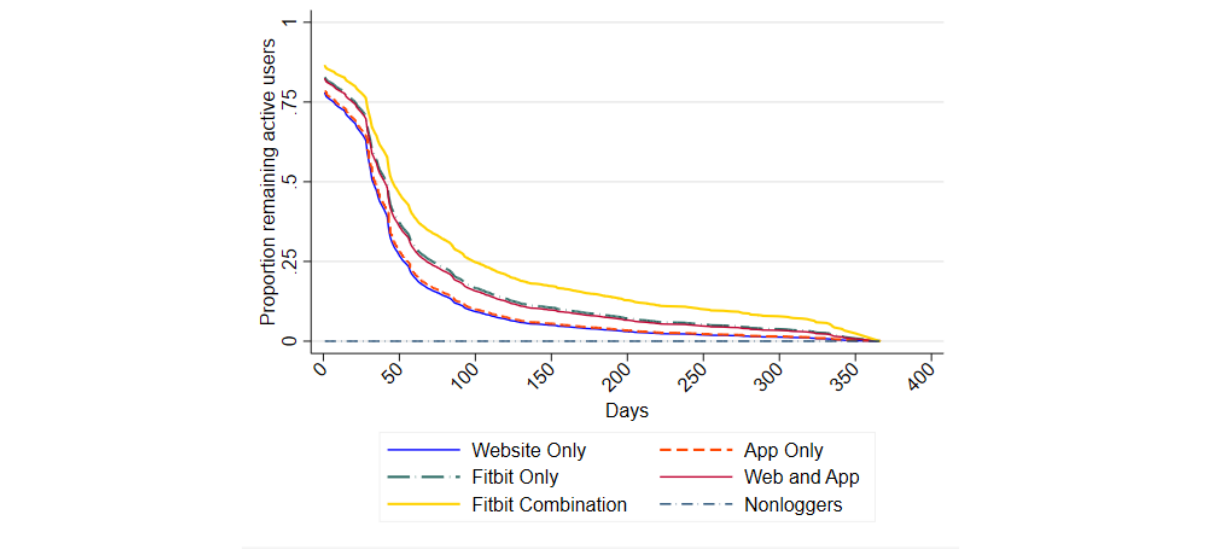
Figure 3. Cox proportional hazards regression curve of the survival distribution for time to nonusage attrition by group based on the model adjusted for Challenges and Tournaments; reference category: did not participate in Challenges or